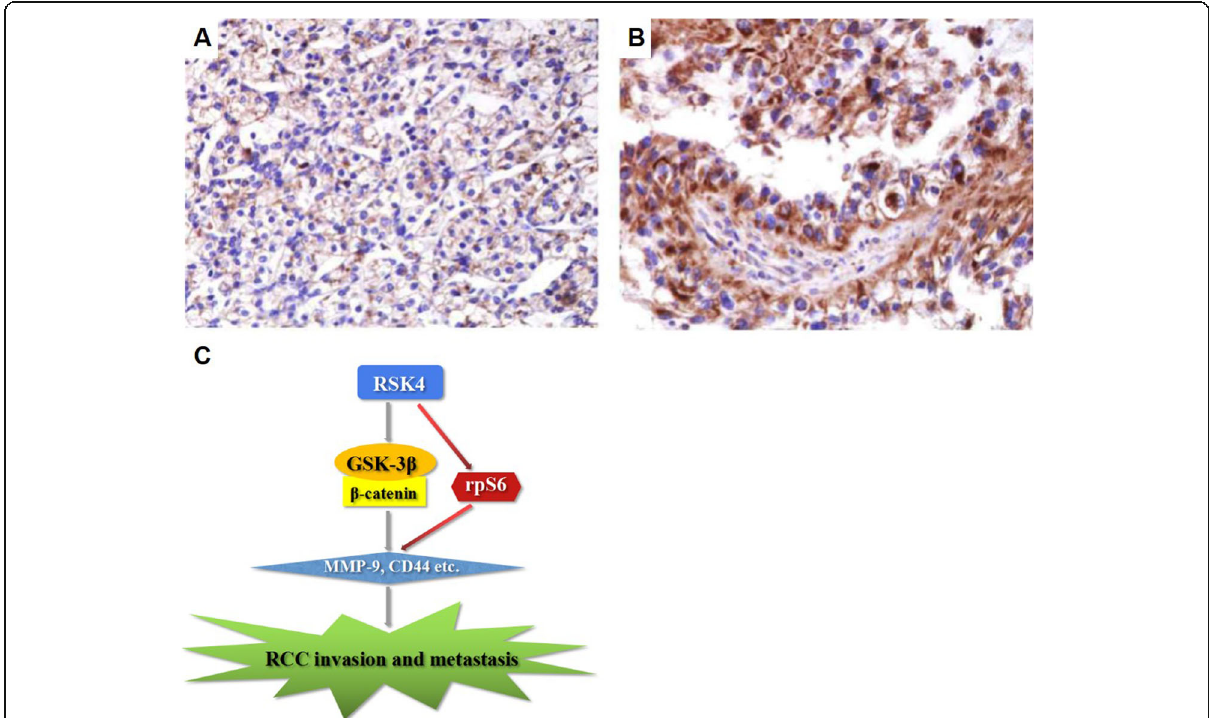
Fig. 4 The expression of β -catenin protein varies in primary ccRCCs and metastatic ccRCCs. a : primary ccRCCs, b : metastatic ccRCCs, ×400. a weak positivity for β -catenin protein. b positivity for β -catenin protein. c Schematic of the pathway of RCC invasion and metastasis. RSK4 may be mediated through the regulation of CD44 and MMP-9 expression, while RSK4-mediated CD44 and MMP-9 may be mediated through the GSK 3 β , β -catenin pathway or rps6 phosphorylation